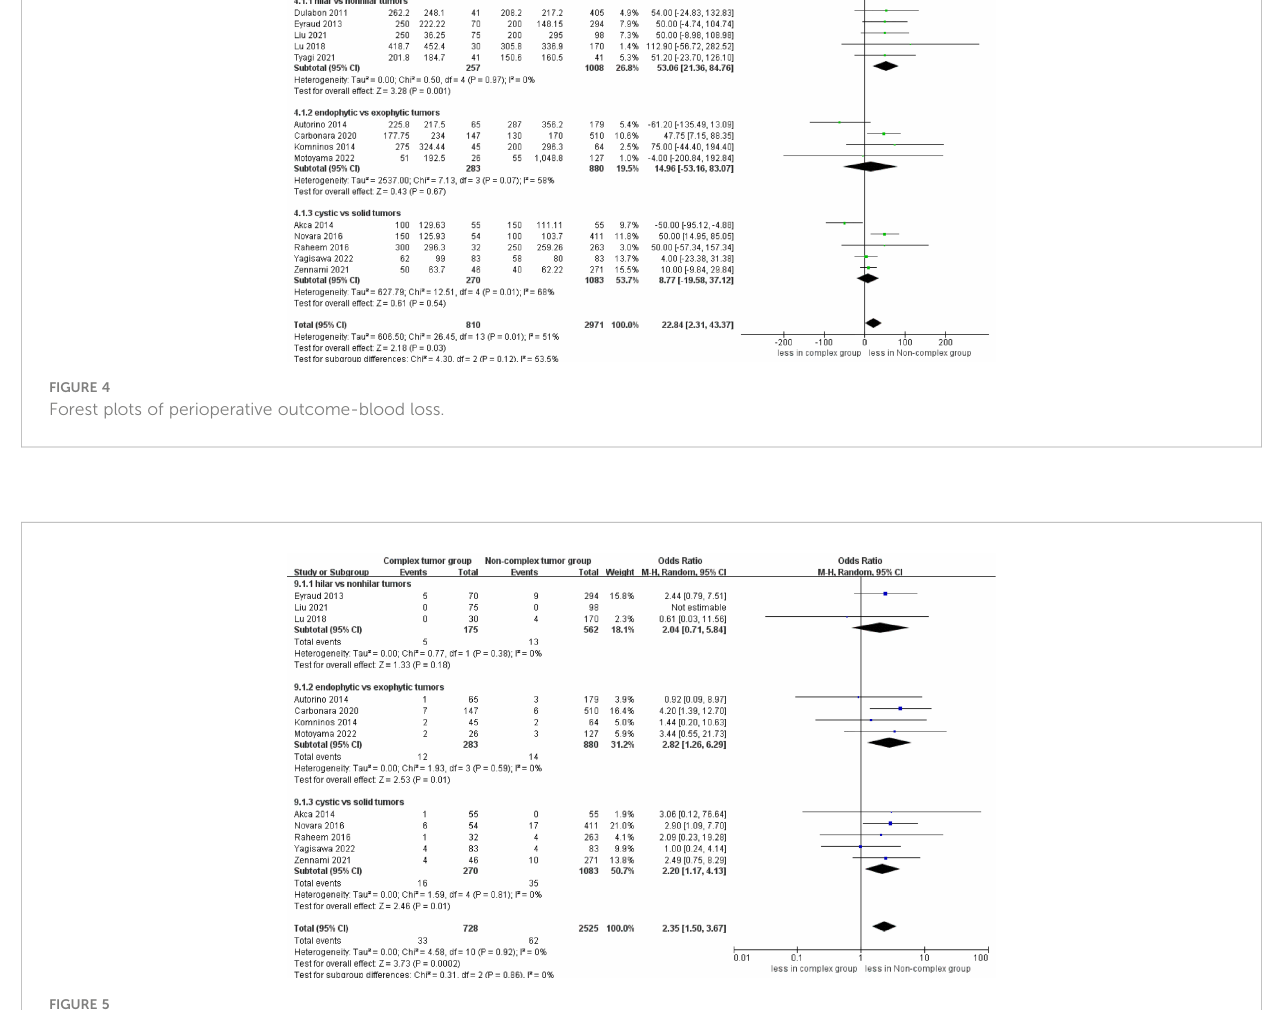
FIGURE 5 Forest plots of complication- major complications.